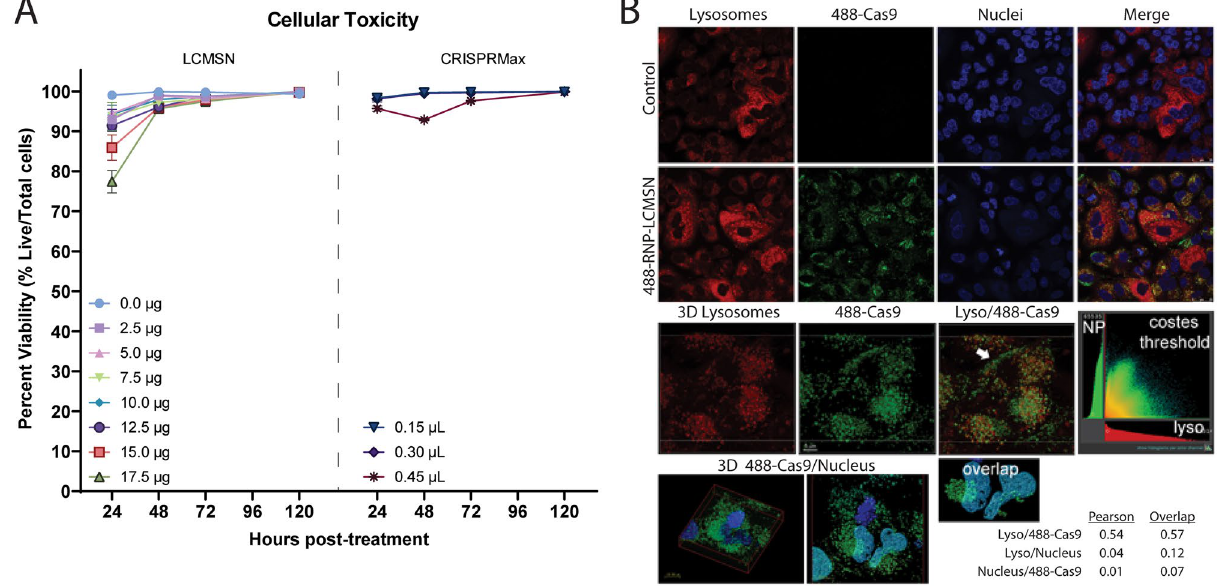
Figure 4. LCMSN cellular delivery occurs via an endosomal pathway with limited cytotoxicity. ( A ) Toxicity of LCMSNs was compared to CRISPRMax in A549 cells at 24, 48, 72, and 120 h post-treatment. ( B ) Confocal microscopy was performed on cells 24 h post-treatment with Alexafluor 488-tagged RNP LCMSN. Colocalization measurements (Pearson/overlap) between various markers are indicated (lyso = lysosome; NP =